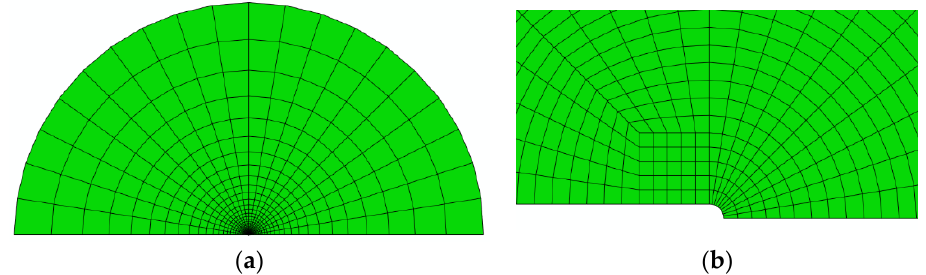
Figure 5. Finite element mesh of the modified boundary layer (MBL) model. ( a ) Global mesh; ( b ) local mesh around crack tip region.